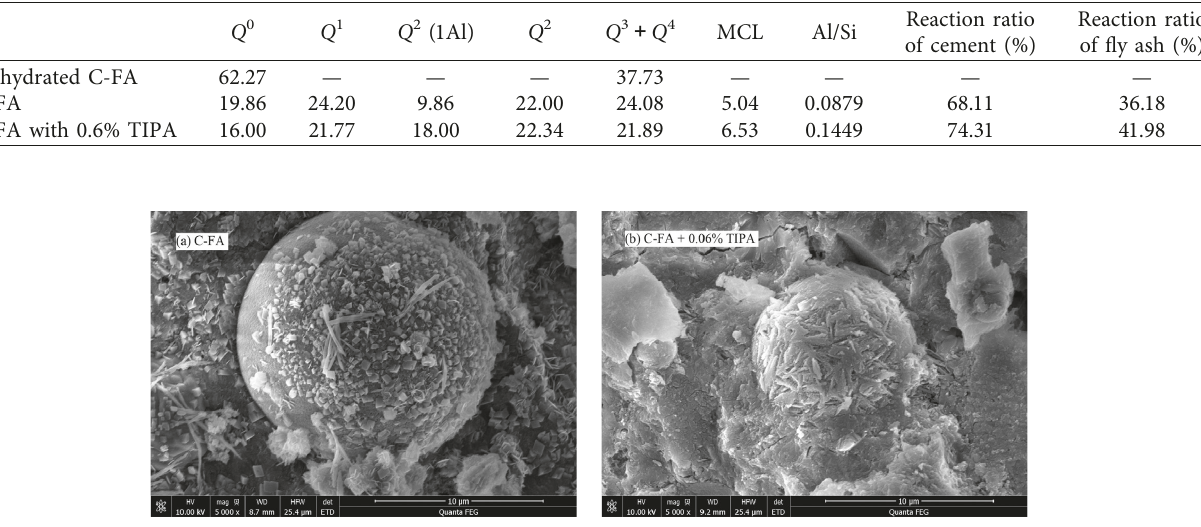
Table 3: Deconvolution results of the